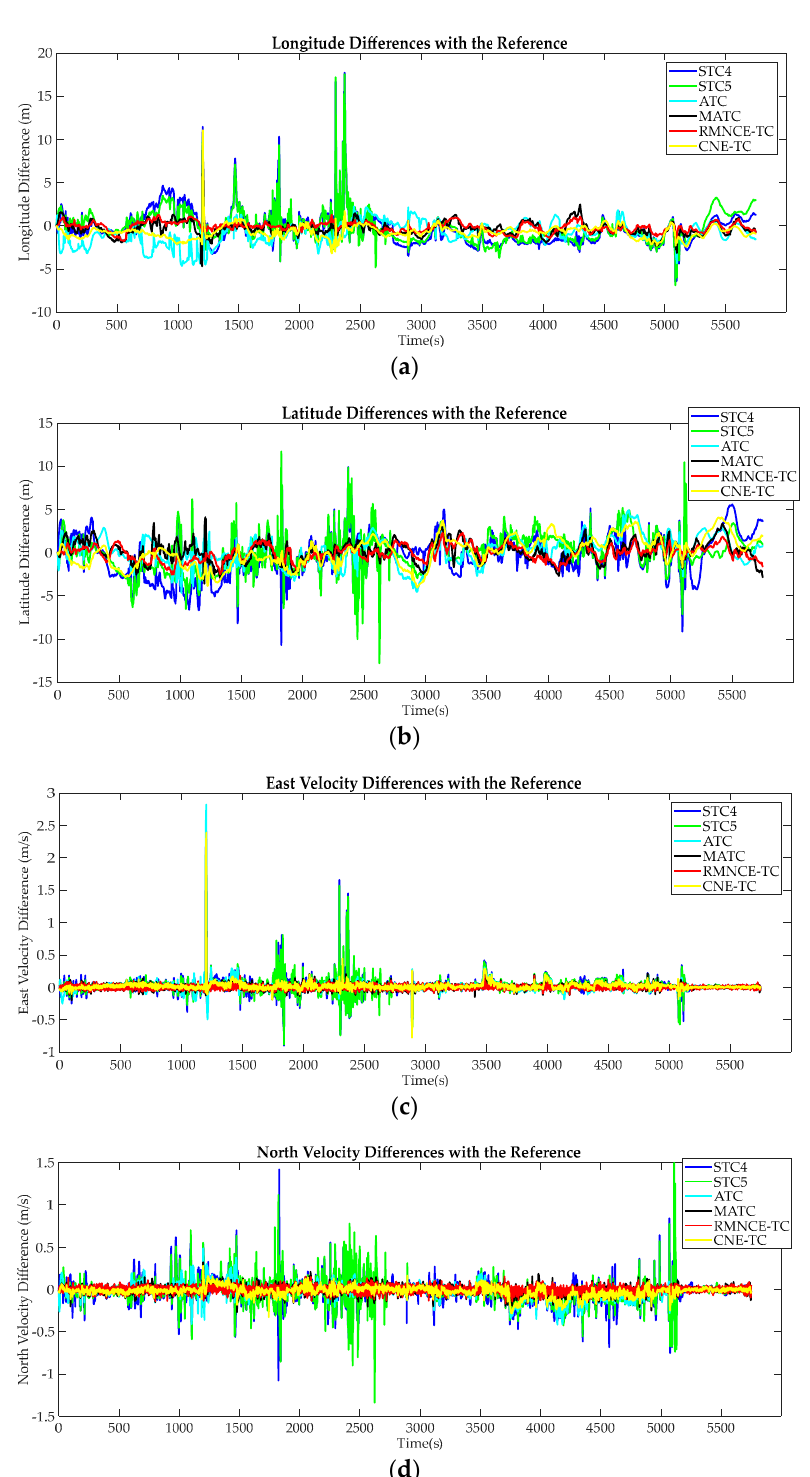
Figure 12. Navigation differences with respect to the reference trajectory using STC4, STC5, ATC, MATC RMNCE-TC and CNE-TC: ( a ) longitude differences (m); ( b ) latitude differences (m); ( c ) east velocity differences (m/s); ( d ) north velocity differences (m/s).